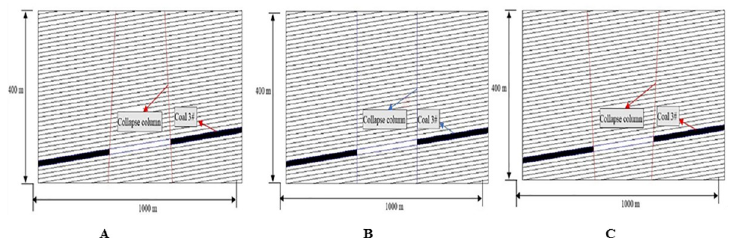
Fig 11. Numerical models of three typical shaped collapse column along mining trend. (A) Inverted funnel shaped. (B) Columnar shaped. (C) Funnel shaped.